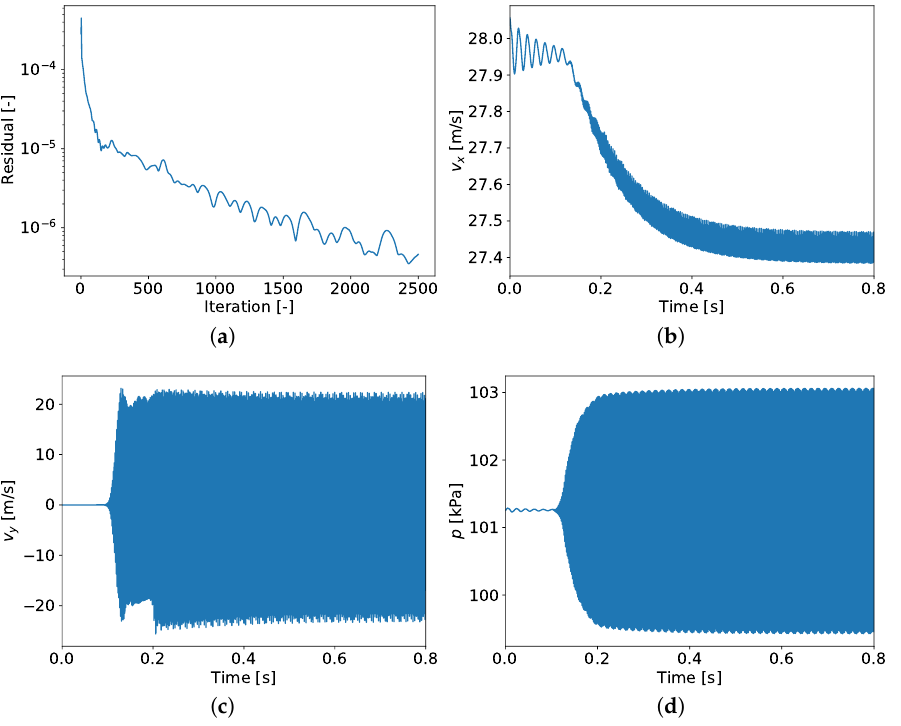
Figure 5. Simulation for target velocity v x = 28m/s. ( a ) Residual in steady simulation; ( b ) Unsteady axial flow velocity; ( c ) Unsteady vertical velocity in wake; ( d ) Unsteady mid-chord wall pressure.